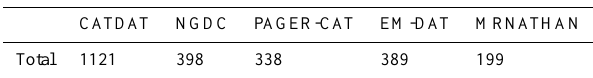
Fig. 13. The number of earthquakes with exact economic loss es- timates per decade in each of the major international earthquake databases as compared to CATDAT v4.12 (Daniell, 2010a). Table 4. The number of earthquakes from 1900–2008 with exact economic loss